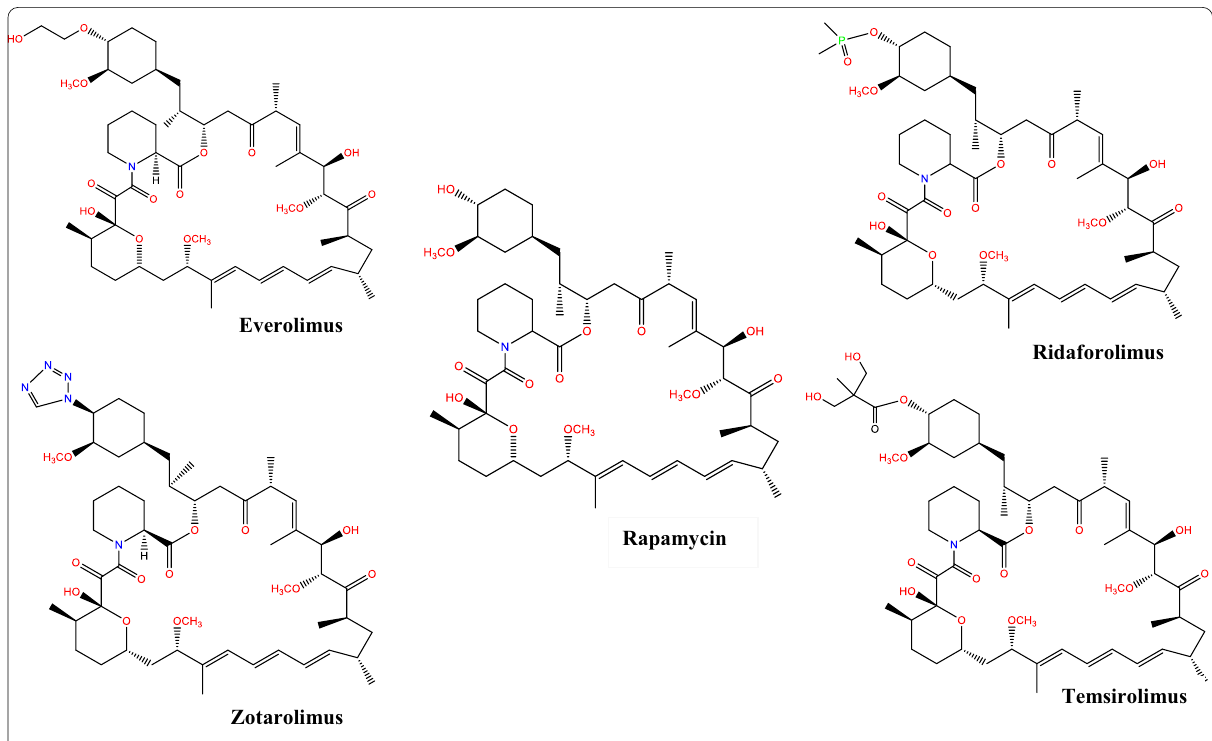
Fig. 2 Chemical structure of rapamycin and some of its